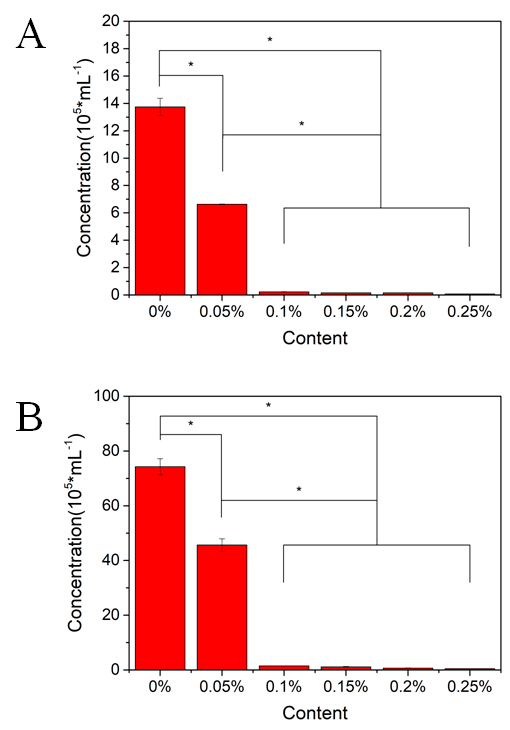
Figure 7. Antibacterial activity of PMMA resin containing CNCs-Ag with different mass concentrations. The composites were co-culturing with: ( A ) Staphyloccocus aureus ; ( B ) Escherichia coli .